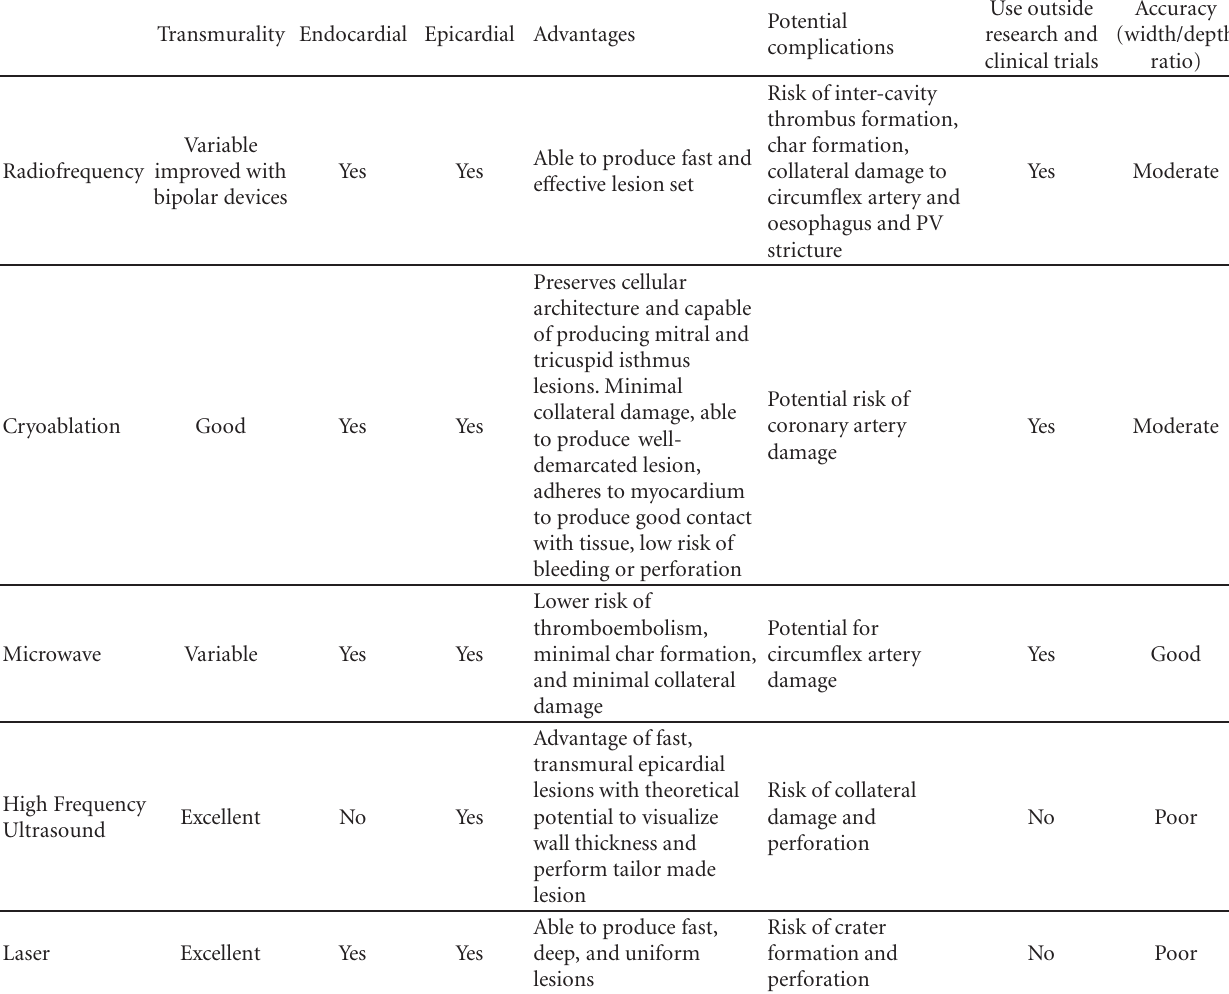
Table 4: Comparison of ablative